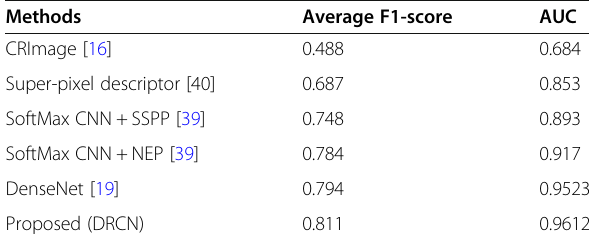
Table 2 Nuclei classification accuracy and comparison against other machine learning and deep learning methods